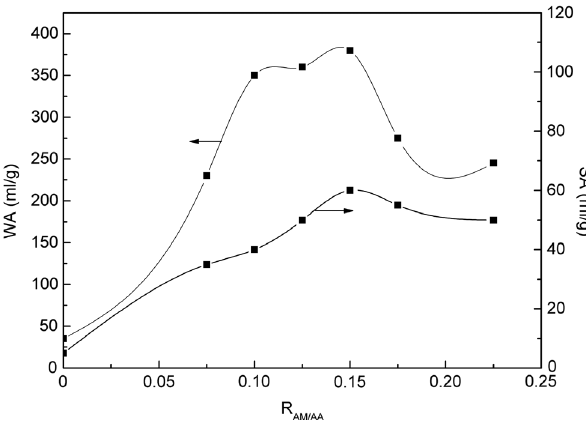
Figure 4 Effect of AM content on the property of SAR salt